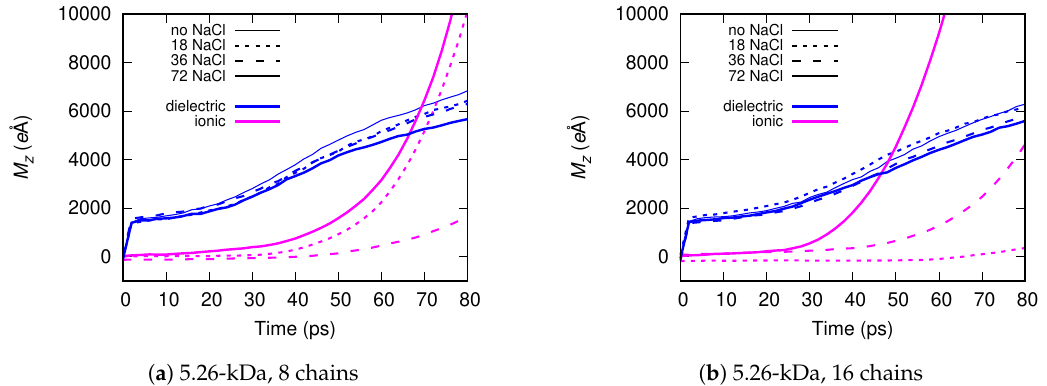
Figure 20. The z -component, M z , of dipole moments generated by PEG/water molecules (blue) and ions (magenta) for different numbers of NaCl ion pairs (distinguished by dashing patterns, see the legend) under 1.5 V/nm. Systems with ( a ) eight or ( b ) sixteen 5.26-kDa PEG chains were used. Plotted with gnuplot